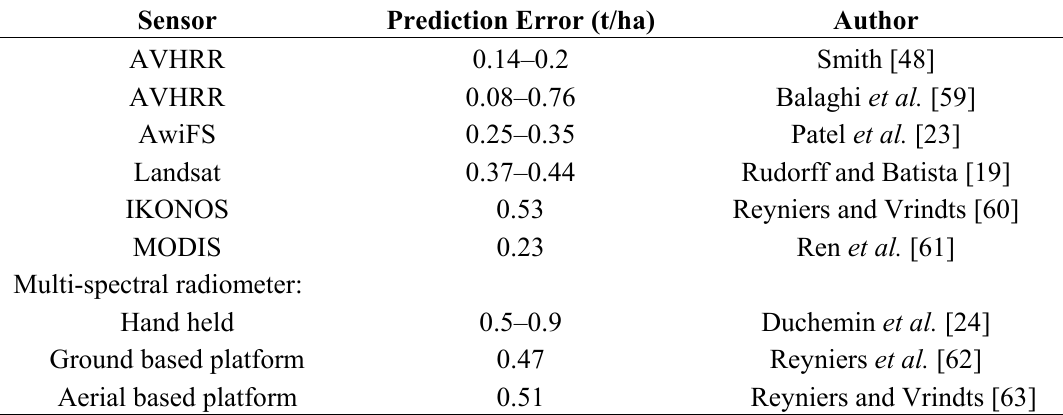
Table 9. Sensor and prediction error associated with wheat yield